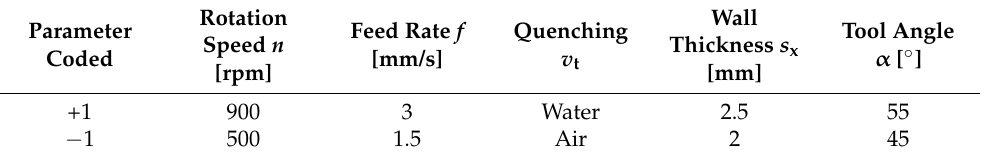
Table 3. Process parameters for the friction-spinning of aluminium 6060 T6